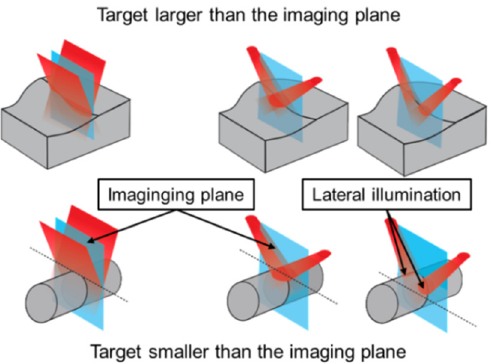
Figure 5. Normalized fluence maps obtained by Monte Carlo simulation for targets larger ( a – c ) and smaller ( e – g ) than the image width. An intermediate situation representing a mouse torso was also considered ( i – k ). All cases were simulated for the bright-field, standard dark-field, and long-axis lateral illumination schemes. Average fluence values were estimated within regions of interest (ROIs) A, B, and C for all cases ( d , h , and I ).